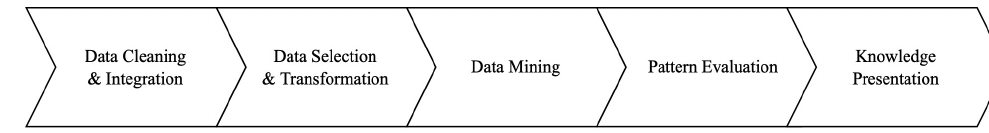
Figure 5. The steps of data mining and knowledge